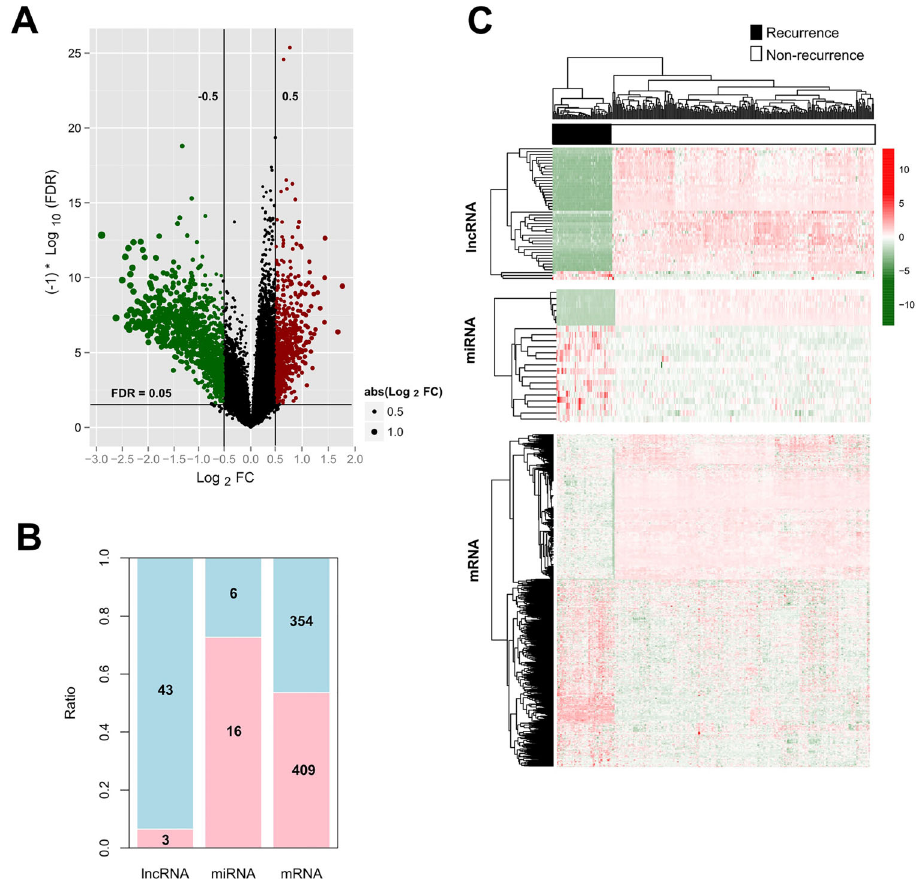
Figure 1. Identi fi cation of differentially expressed RNAs between recurrent and non-recurrent cervical cancer samples. A , Volcano plot to show the distribution of differentially expressed RNAs (green dots, downregulated; red dots, upregulated). FC: fold change; FDR: false discovery rate. B , Upregulated and downregulated number of differentially expressed mRNAs, lncRNAs, and miRNAs. C , Heat map of differentially expressed mRNAs, lncRNAs, and miRNAs. Red: high expression; green: low